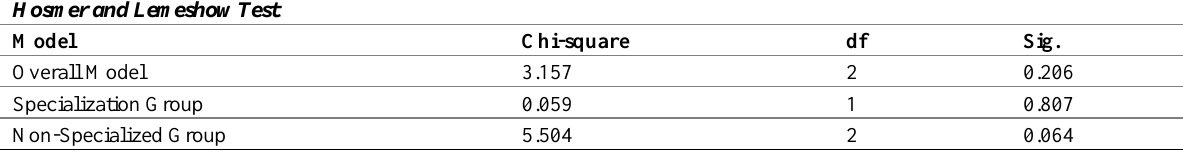
Table 4: Model Accuracy